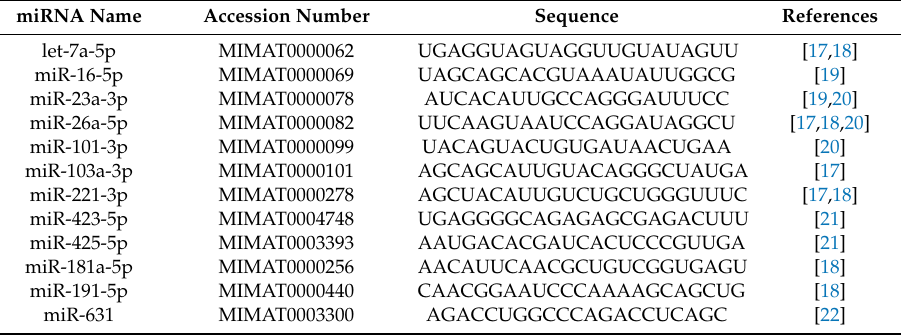
Table 1. Selected endogenous reference micro-ribonucleic acid (miRNA) candidates.